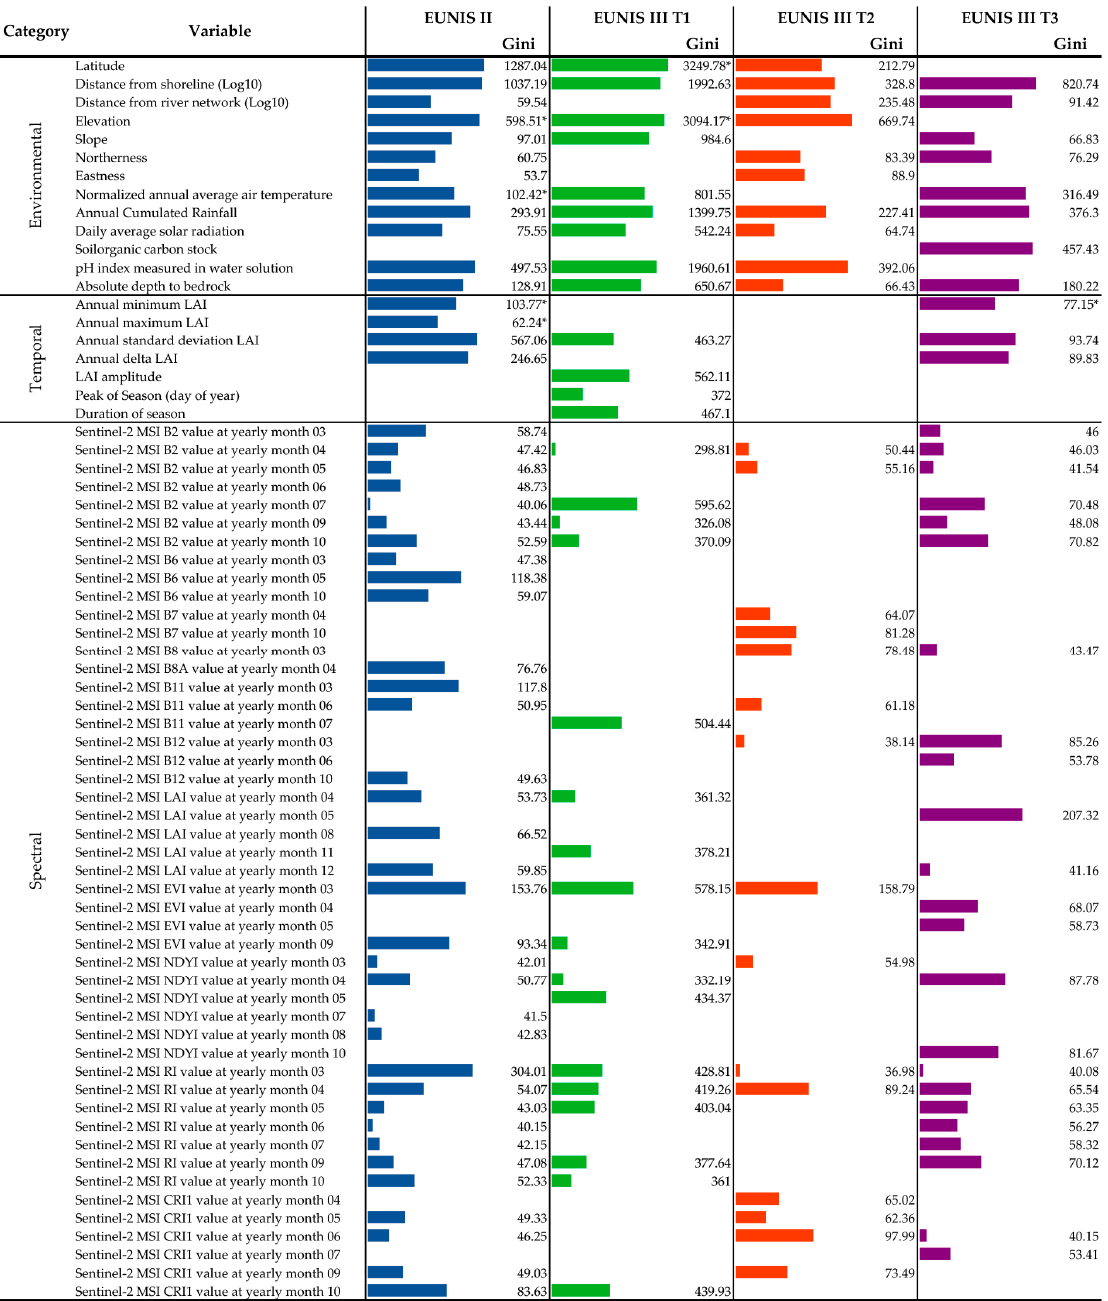
Figure 4. List of environmental, temporal and spectral predictors selected after multi-collinearity and expert-based analysis for each EUNIS II and III hierarchical level. Gini index values are reported for each Random Forest (RF) model: EUNIS II; T1 = Broadleaved Decidous; T2 = Breoadleaved Evergreen; T3 = Needleleaved. Colored bars represent the variable importance ranking, based on the Gini index value. Only variables with colored bars were selected as predictors in the model. * reconsidered variable through expert-based selection procedure.